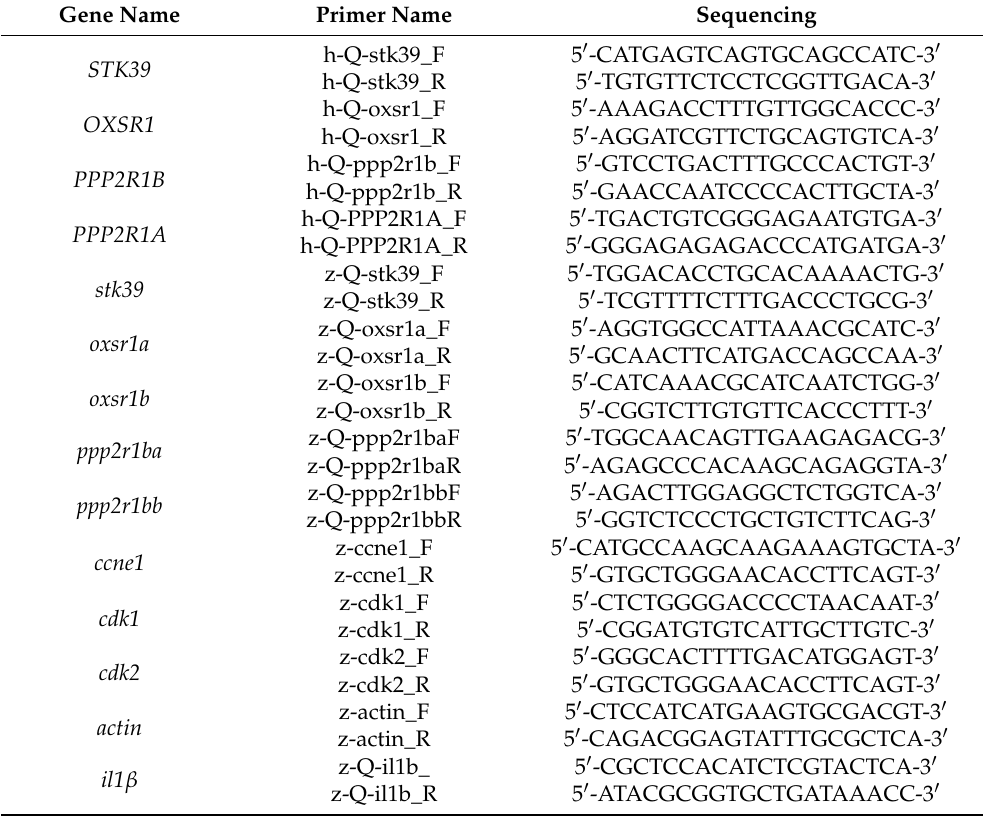
Table 2. Primer information.